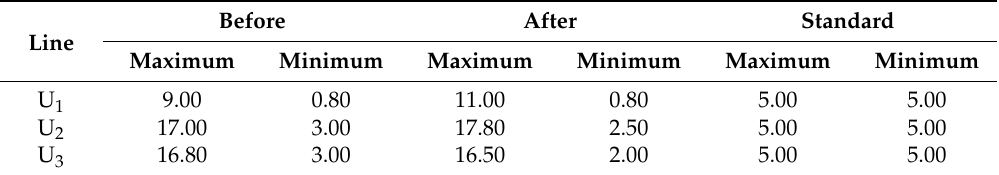
Table 7. Comparison of Total Harmonic Distortion (TDDI).